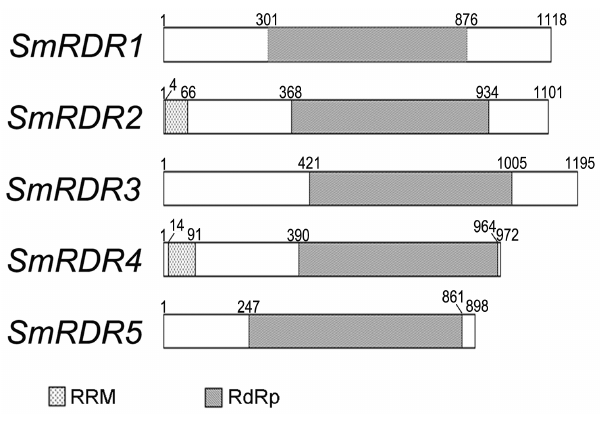
Figure 2. Conserved domains in SmRDR proteins. Boxes with points represent the RRM domain. Grey boxes represent the RdRp domain. The first and the last amino acids of SmRDR proteins and the location of RRM and RdRp domains are numbered.